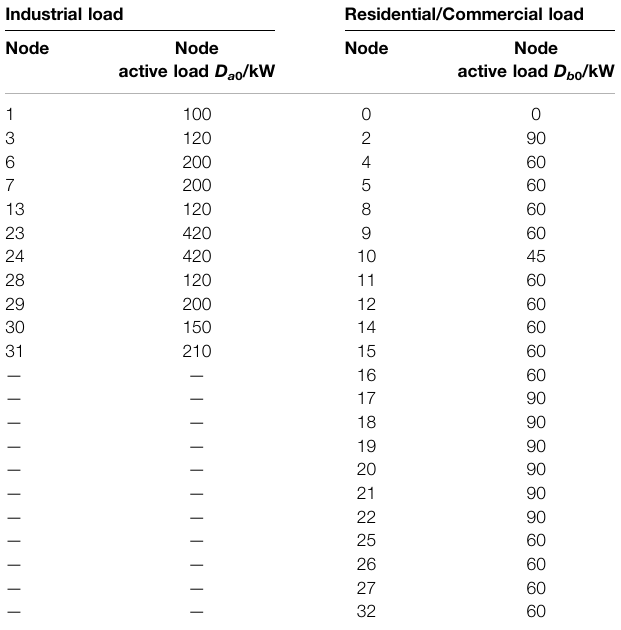
TABLE 2 | IEEE-33 node distribution system parameter value. Industrial load